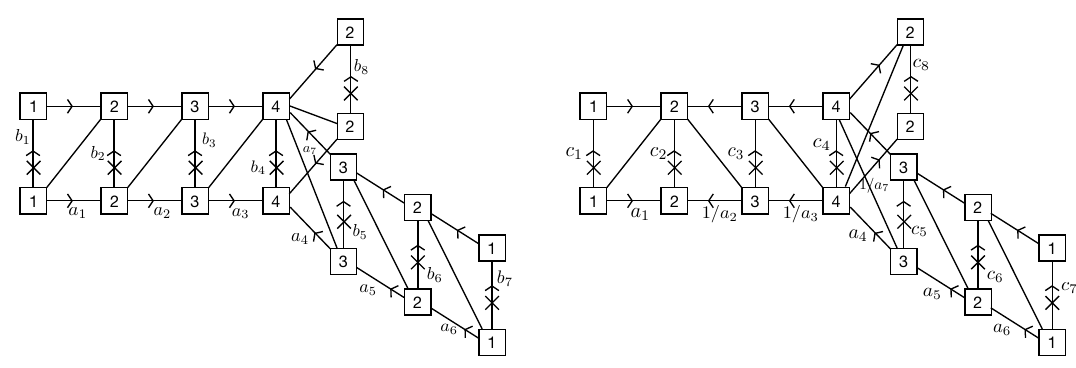
Figure 16 . Basic domain walls in the a(cid:14)ne E 7 quiver theory with D 1 = f + 7 g (cid:12) and D 2 = symmetries at the